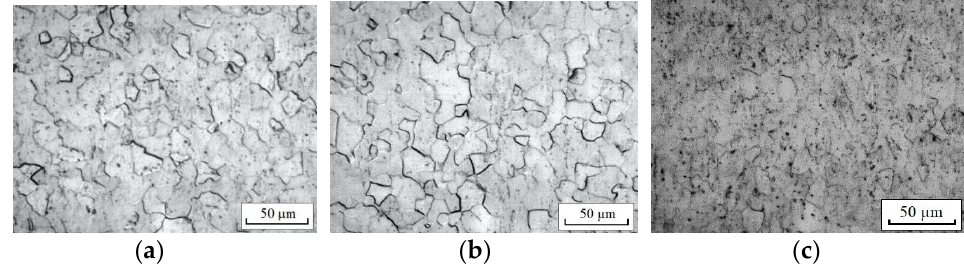
Materials 2022 , 15 , x FOR PEER REVIEW Figure 5. Microstructure of CG titanium tested with current (60 А/mm 2 , 500 μs, 200 °С) : Figure 5. Microstructure of CG titanium tested with current (60 A/mm 2 , 500 µ s, 200 ◦ C): a — undeformed zone; b — deformed zone; c — neck. ( a )—undeformed zone; ( b )—deformed zone; ( c )—neck.